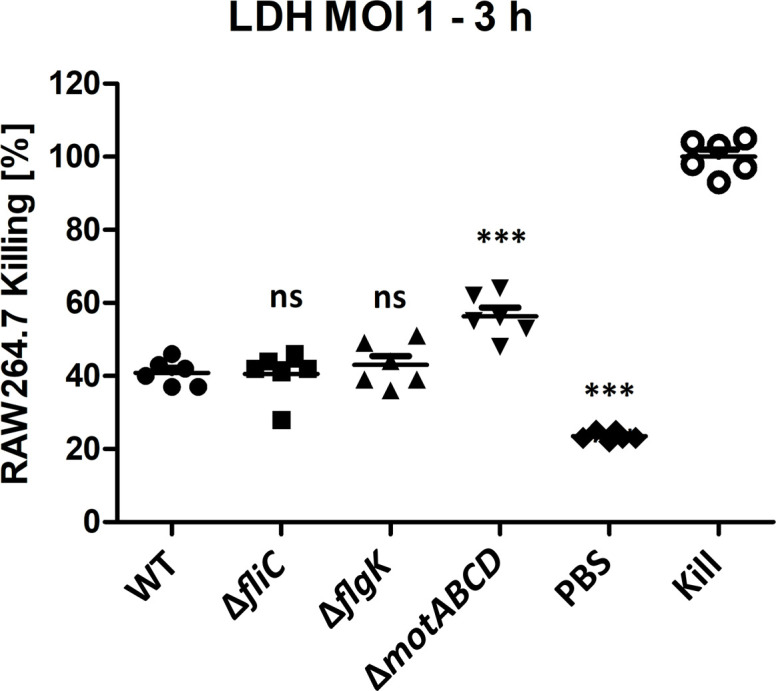
Lactate Dehydrogenase (LDH) assay of infected RAW264.7 macrophages.RAW macrophages were infected with 5 × 105 – MOI 1 for 3 hr without gentamycin treatment to simulate the dual-sequencing experiment. PBS served as the negative and 10% (v/v) Triton-X100 as killing control. Mean ± standard deviation of six biological replicates from two independent experiments is shown. **p<0.01; ***p<0.001 (one-Way ANOVA, Dunnett’s post-hoc test).